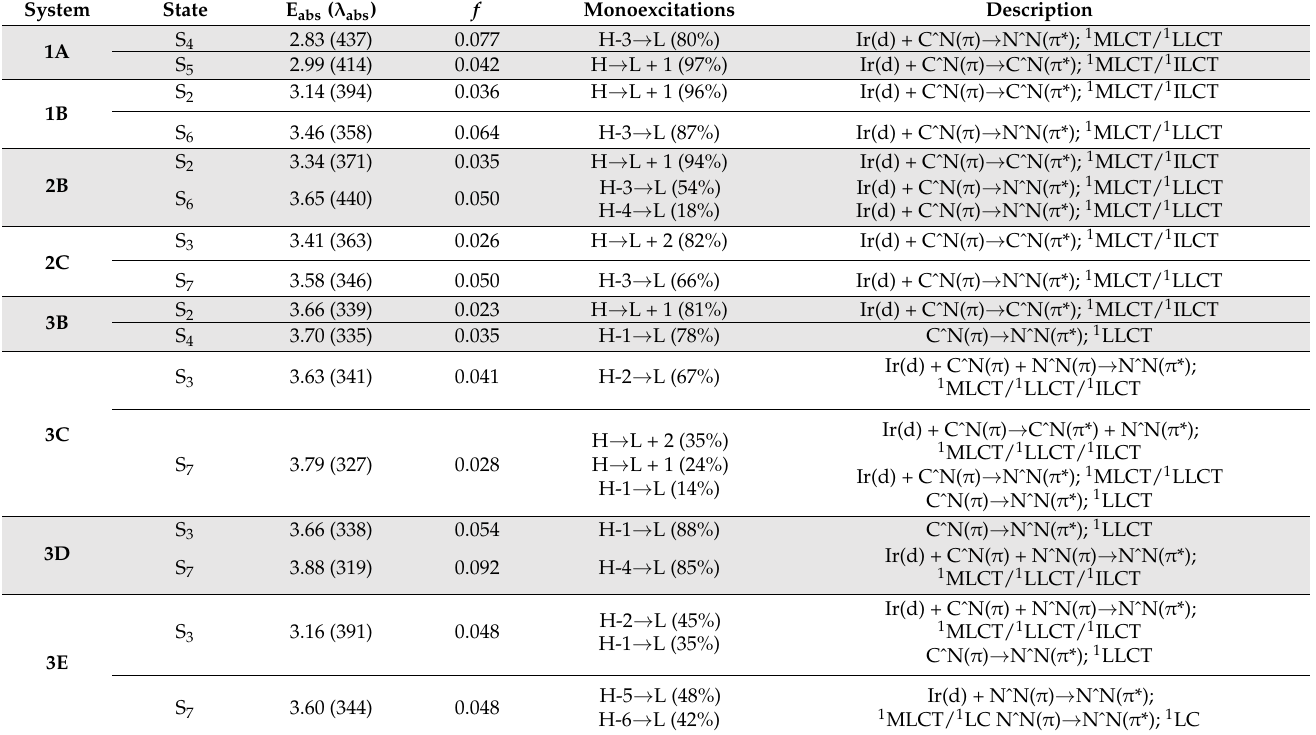
Table 2. Absorption properties calculated from TD-DFT approach, in dichloromethane as solvent. Determined at the B3LYP/6-31G(d)/LANL2DZ level of